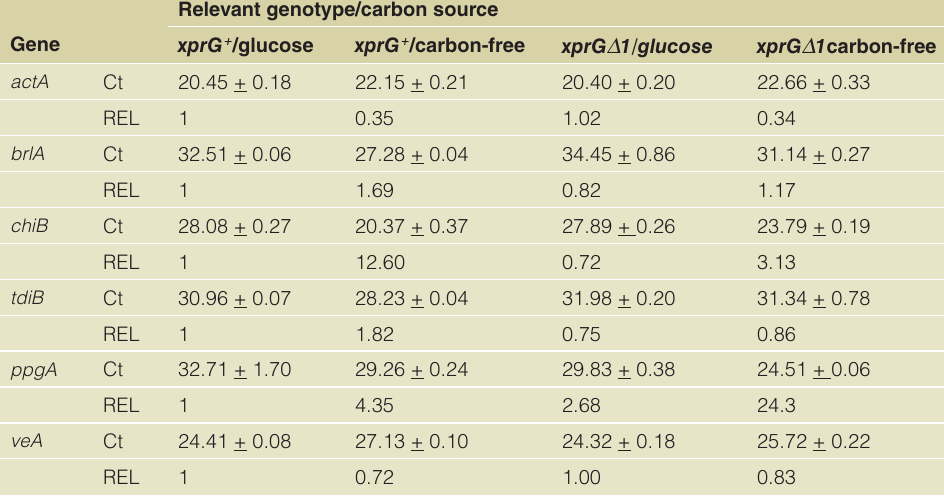
Table 3. Results of qRT-PCR validation experiments a